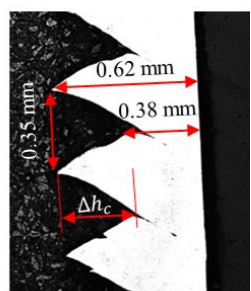
Figure 10. Chip geometry measurement: Maximum chip thickness, minimum chip thickness and pitch. V c = 7.5 m/min and f = 0.4 mm.